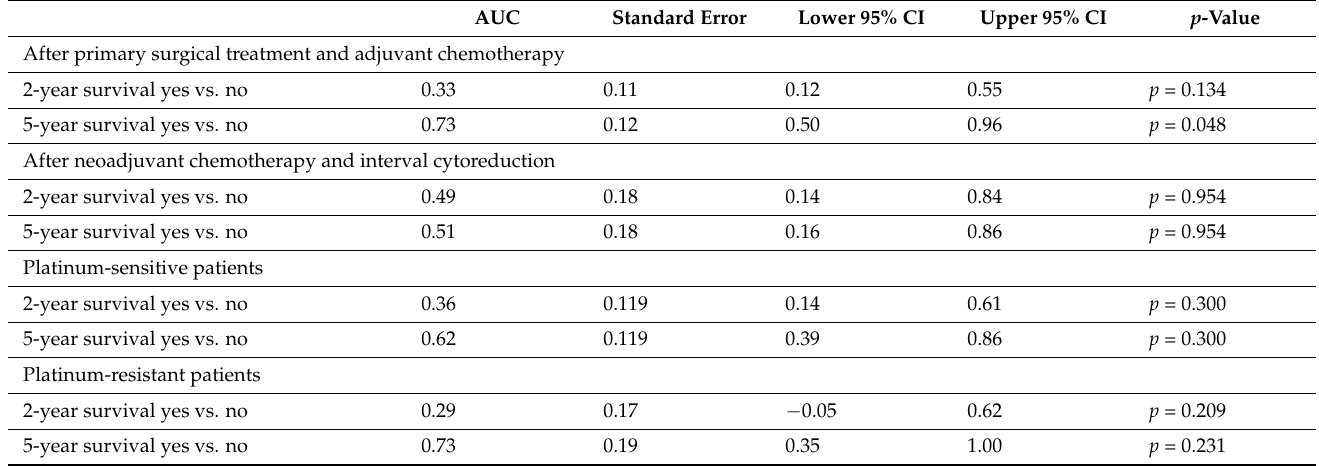
Table A5. Assessment of serum HE4 prognostic value after the third course of third-line chemotherapy treatment.